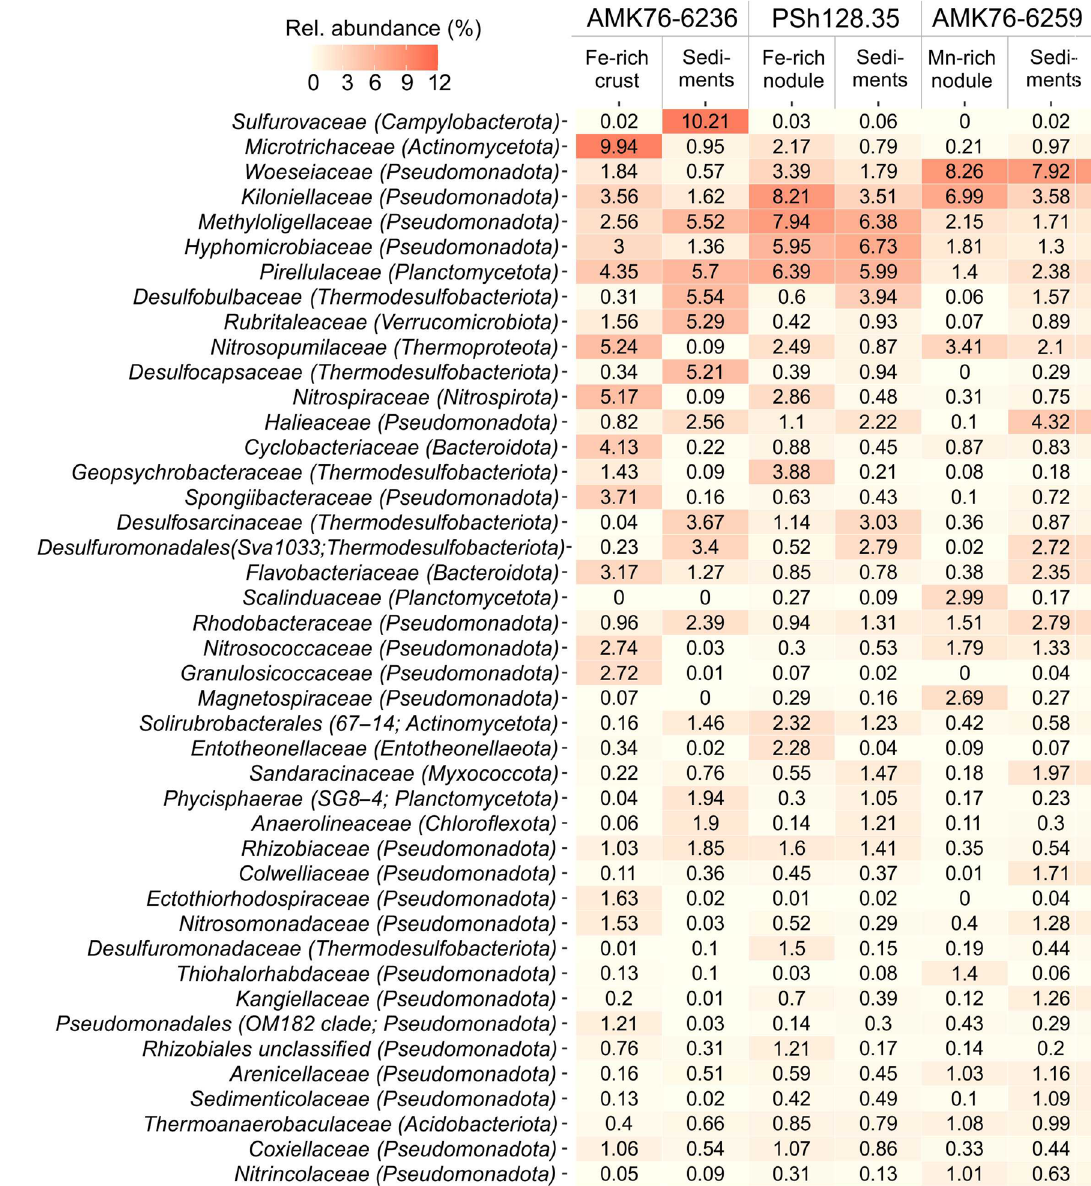
Figure 4. Heatmap illustrating relative 16S rRNA gene sequence abundance (at family level; > 1%) of nodule-, crust-, and sediment-associated microbial communities sampled at sites AMK76-6236, PSh128.35 and AMK76- 6259. Relative abundances of specific taxa represent average value of duplicate samples (Tables